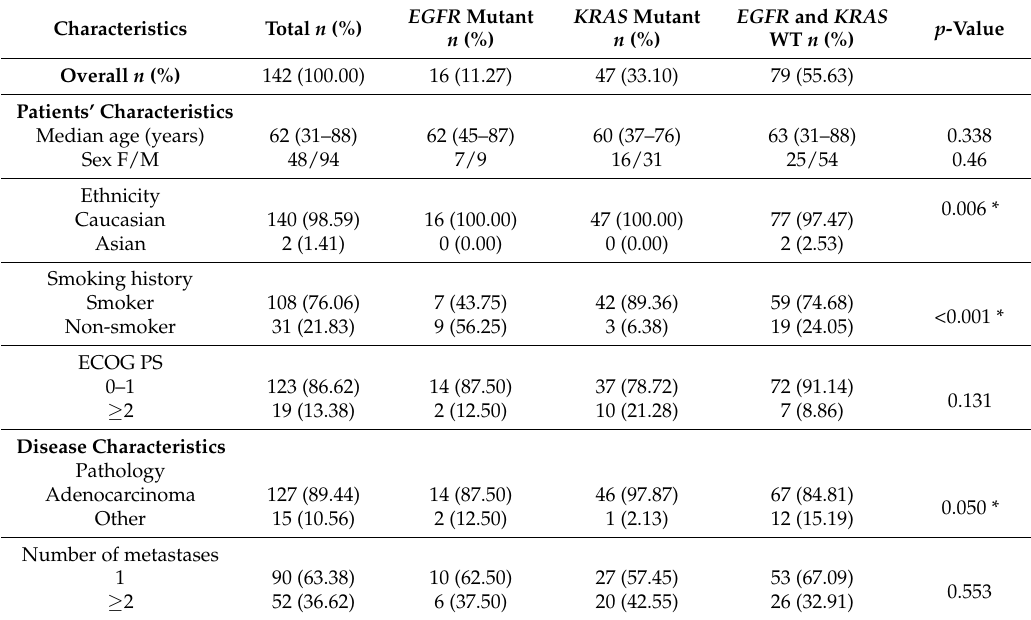
Table 1. Patient and disease characteristics associated with mutation status. WT: wild type; F: female; M: male; ECOG PS: ECOG performance status; *: significant p -values ( p ≤